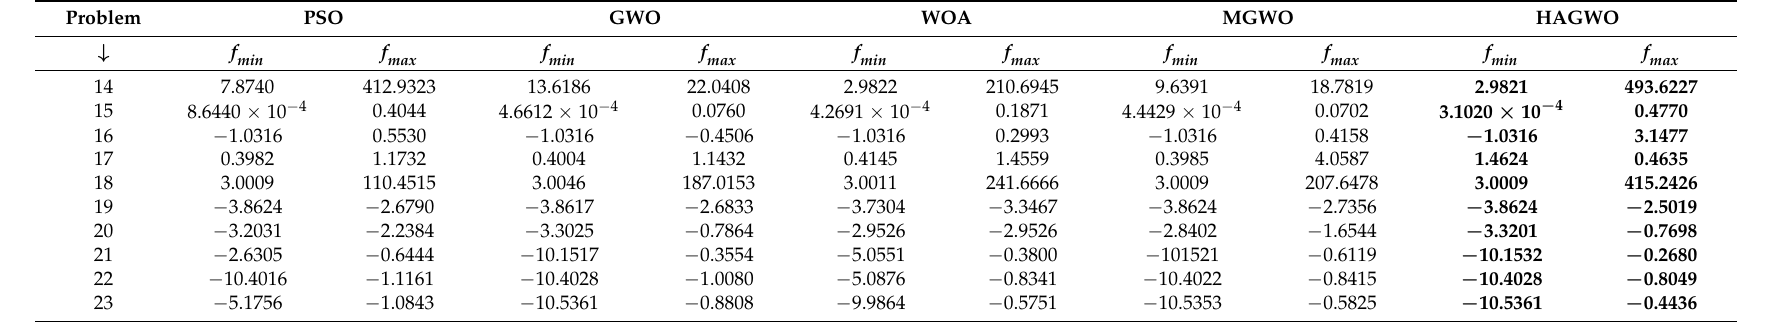
Table 8. Numercial results of fixed-dimension multimodal benchmark